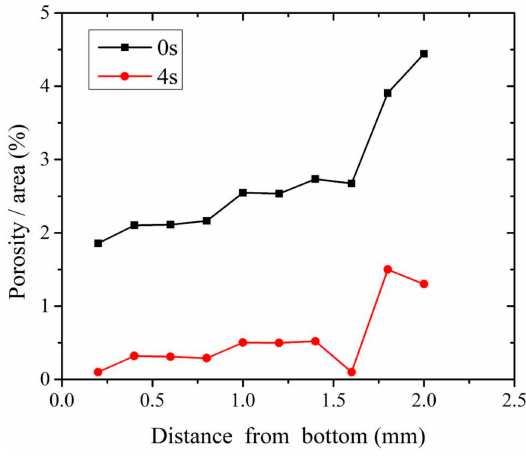
Figure 9. The distribution of porosity from bottom to top surfaces in GTA spot-welded joints with and without USV